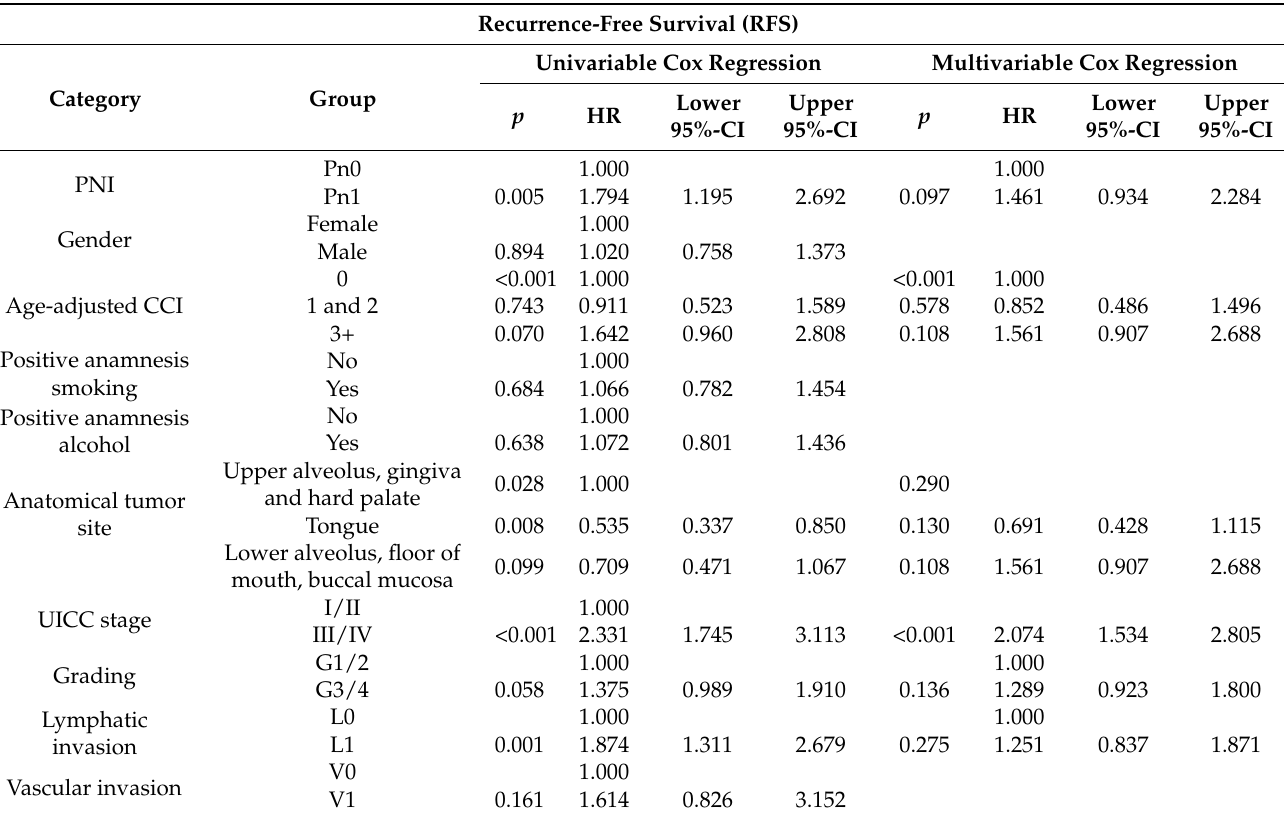
Table 4. Effect of PNI and additional covariables on cumulative RFS using uni- as well as multivari- able Cox